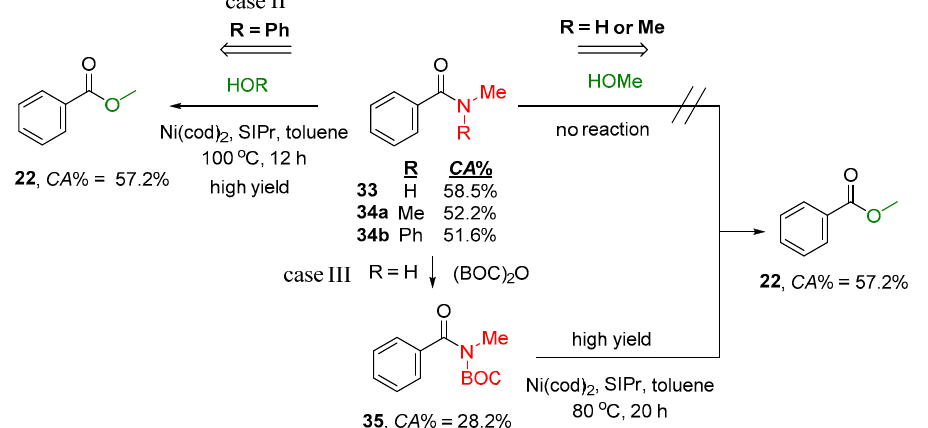
Figure 14. Exemplified acyl transfer reaction (case II and case III) with and without amide activation in the presence of catalyst. The corresponding carbonylicity values were computed at B3LYP/6-31G(d,p) level of theory. BOC = t –BuO–CO–; cod = 1,5-cyclooctadiene; SIPr = 1,3-bis(2,6- diisopropylphenyl)imidazole-2-ylide.